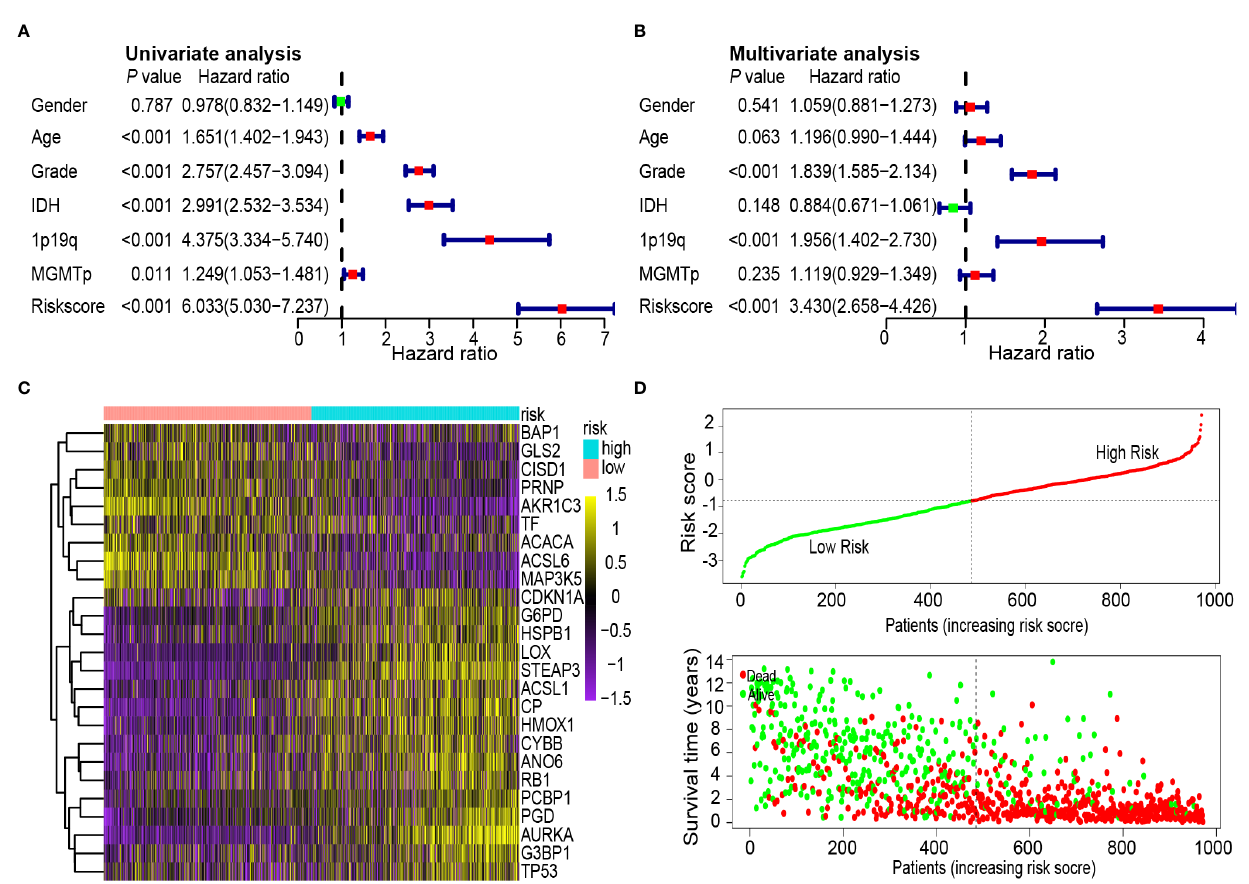
FIGURE 5 | Univariate and multivariate Cox analysis of prognostic risk scores for gliomas, distribution of survival status and heat map. (A) Univariate Cox regression analysis. Forest plot of associations between risk factors and the survival of gliomas. (B) Multiple Cox regression analysis. The ferroptosis-related gene signature is an independent predictor of gliomas. (C) Heat map of ferroptosis-related gene expression pro fi les in the prognostic signature of gliomas. (D) Distribution of risk score and patient survival time, and status of gliomas. The black dotted line is the optimal cut-off value for dividing patients into low-risk and high-risk